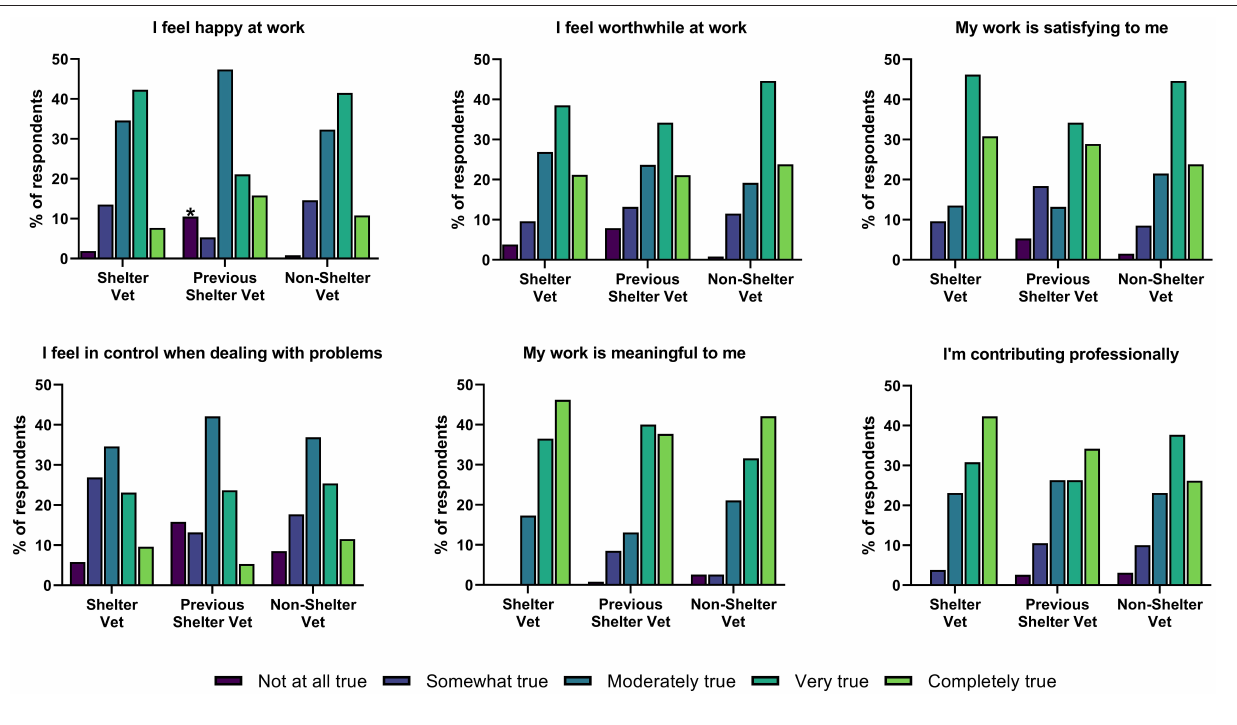
FIGURE 2 | Professional fulfillment in veterinary